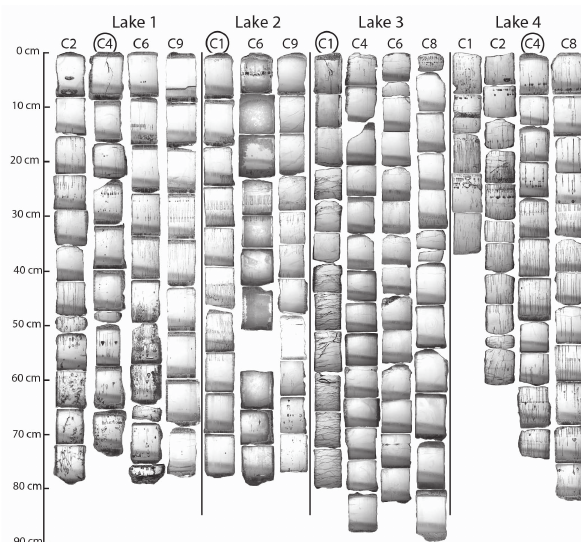
Fig. 3. Ice characteristics, bubbles shapes and distribution in the 15 studied ice cores (see Fig. 2 for location). Circles denote the cores analyzed at high resolution for their gas properties.